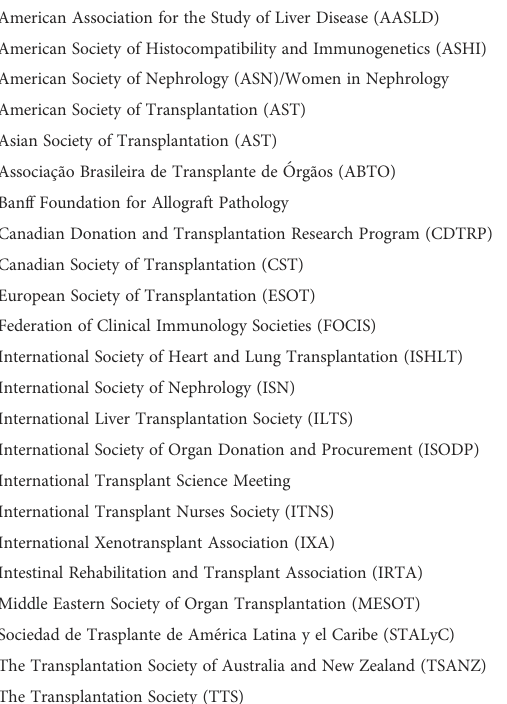
TABLE 2 Collaborative organizations with Women in